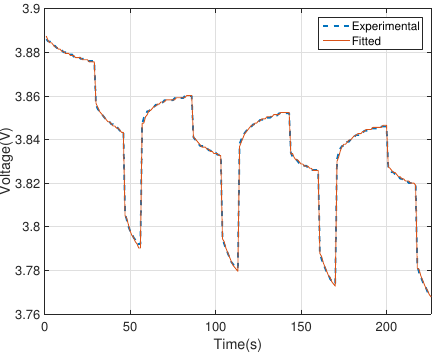
Figure 4. Fitting results of the pulse discharge at SOC =